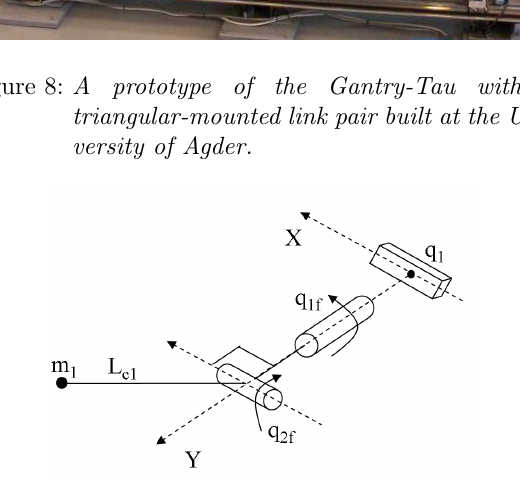
Figure 9: Definitions of the variables at the actuator side for the single link.